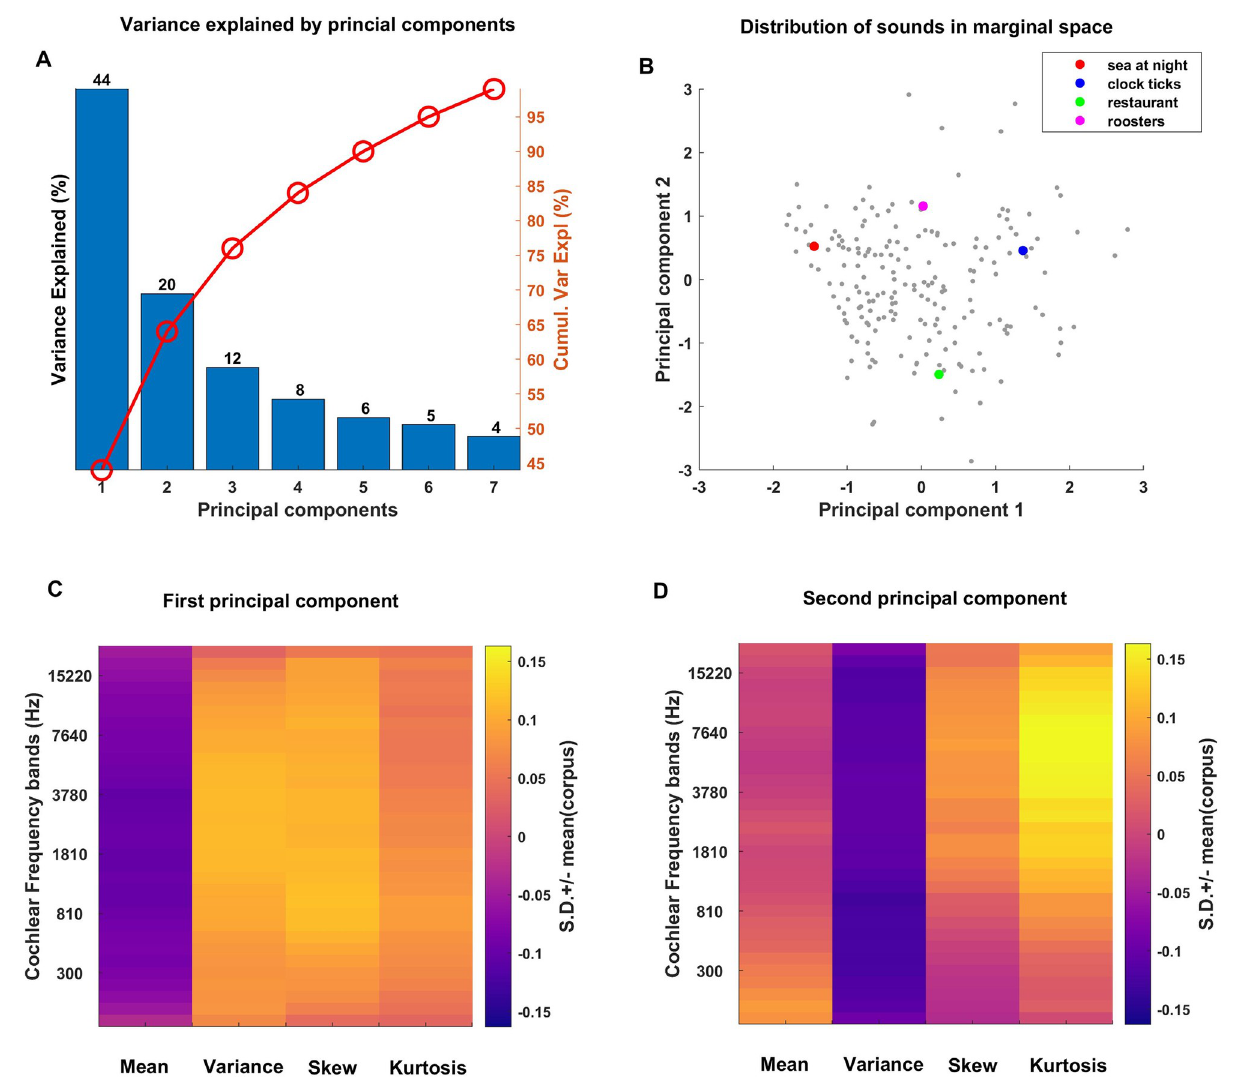
Fig 3. Principal components of the marginal parameters. (A) Percent variance explained by the first 7 PCs of the marginal parameters. The red line over (A) shows the cumulative variance explained by the principal components. The first two PCs capture 64% of the variance explained. (B) Distribution of the sounds in our corpus along the first two PCs of the marginals. Four example sound textures examined further in Fig 4 are highlighted in color. (C, D) Shape of the first and second PCs of the marginals, respectively. The 1st PC distinguishes textures of relatively low mean and high variance, skew and kurtosis from textures for which the reverse is true. The 2nd PC has mean and skew values that are near zero, and thus mostly distinguishes textures with low variance and but high kurtosis, particularly for frequency bands above 800 Hz, from sounds with the opposite feature